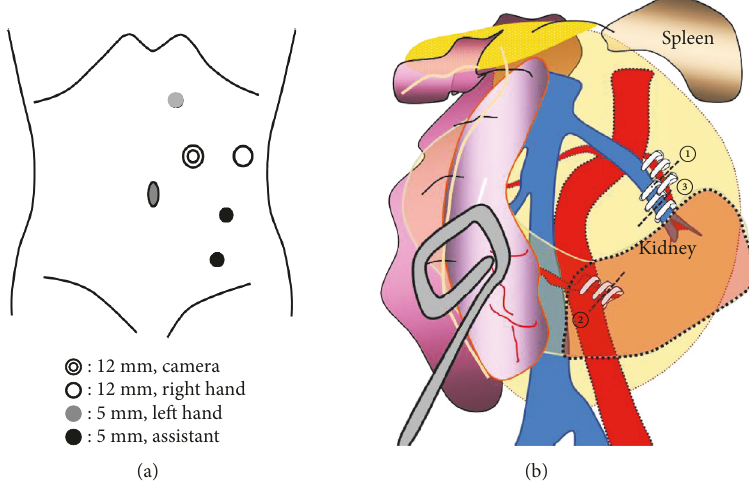
Figure 2: (a) Laparoscopic ports used in this case. (b) Schema of procedure for ligation of the left renal vascular system. The main renal artery and an aberrant renal artery were ligated and divided in that order; then the renal vein was cut.